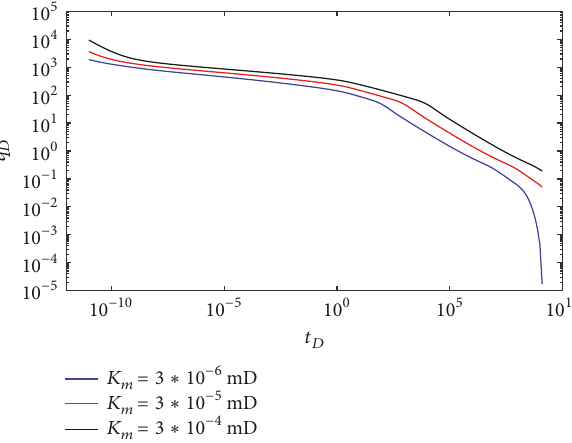
Figure 10: Effect of matrix radius on production.